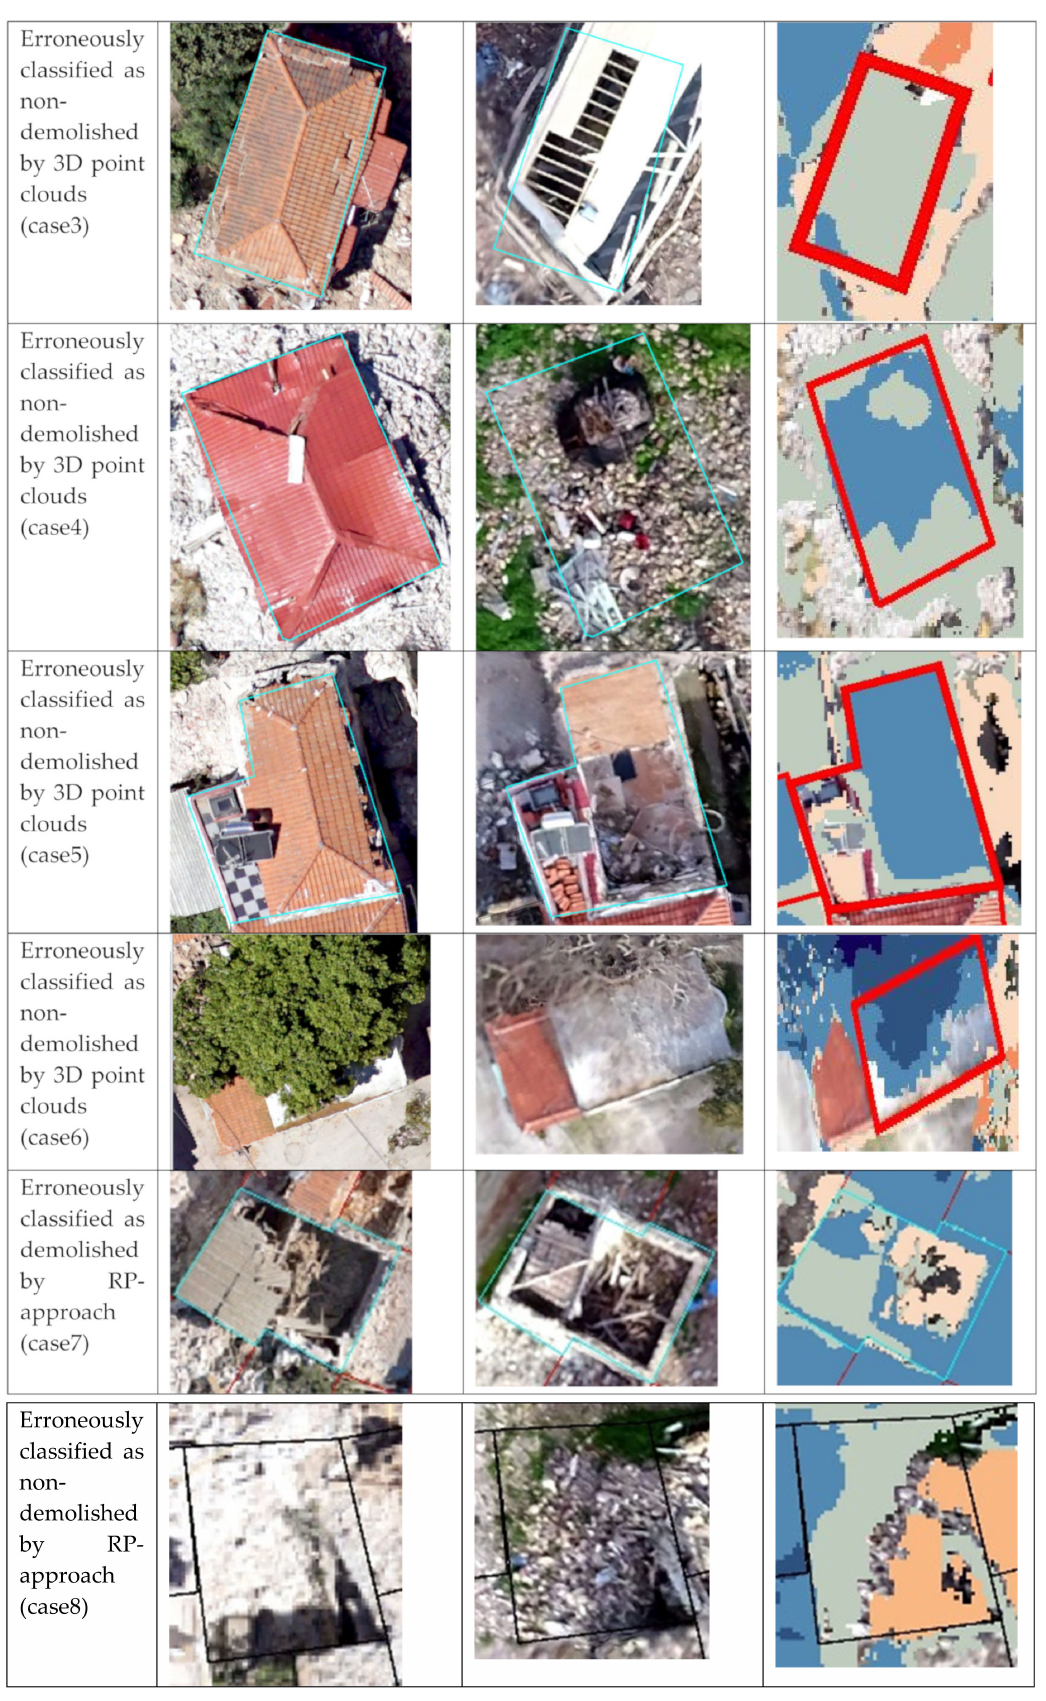
Figure A1. Di ff erent cases of omission and commission